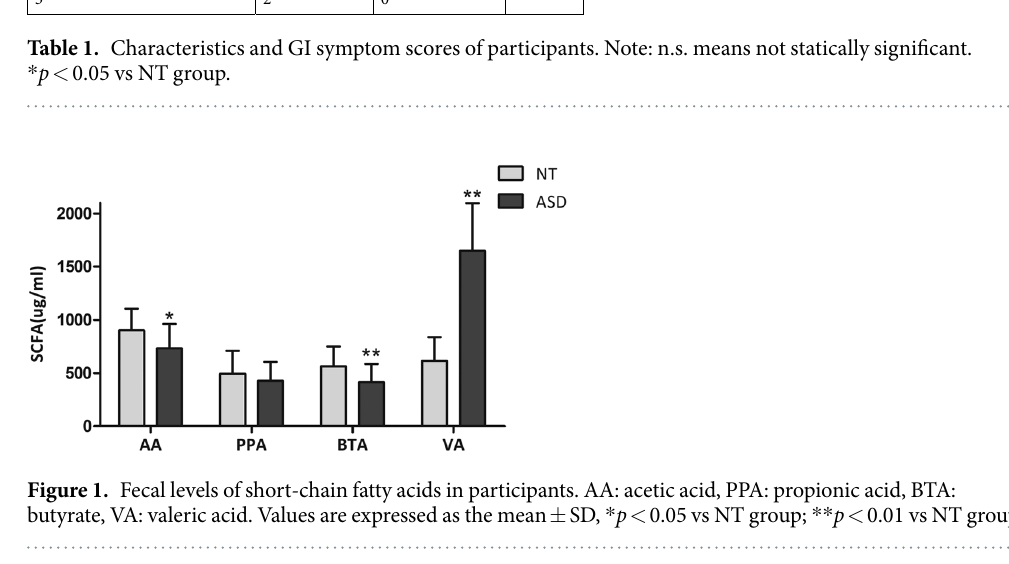
(2019) 9:287 | DOI:10.1038/s41598-018-36430-z